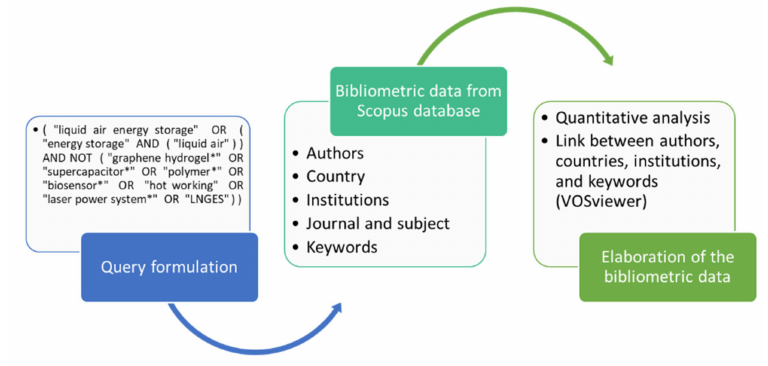
Figure 2. Methodology used for the bibliometric